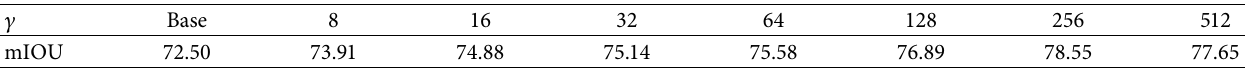
Table 2: Experimental results of setting different reduction ratios c using the CA-Bottleneck module in Res-2. The score is evaluated by standard mean IOU (%) on insulator test dataset.